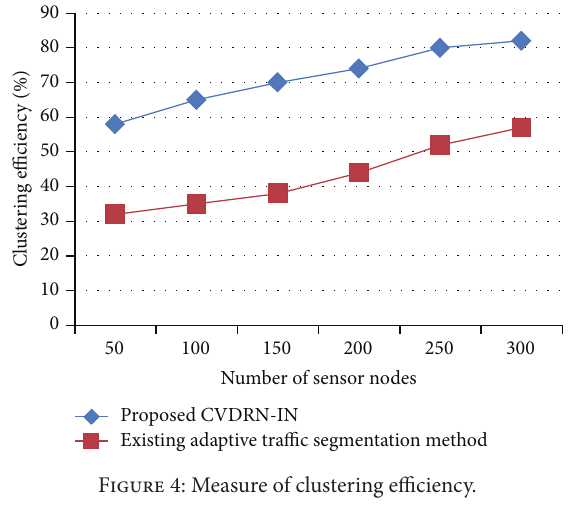
Figure 4: Measure of clustering efficiency.